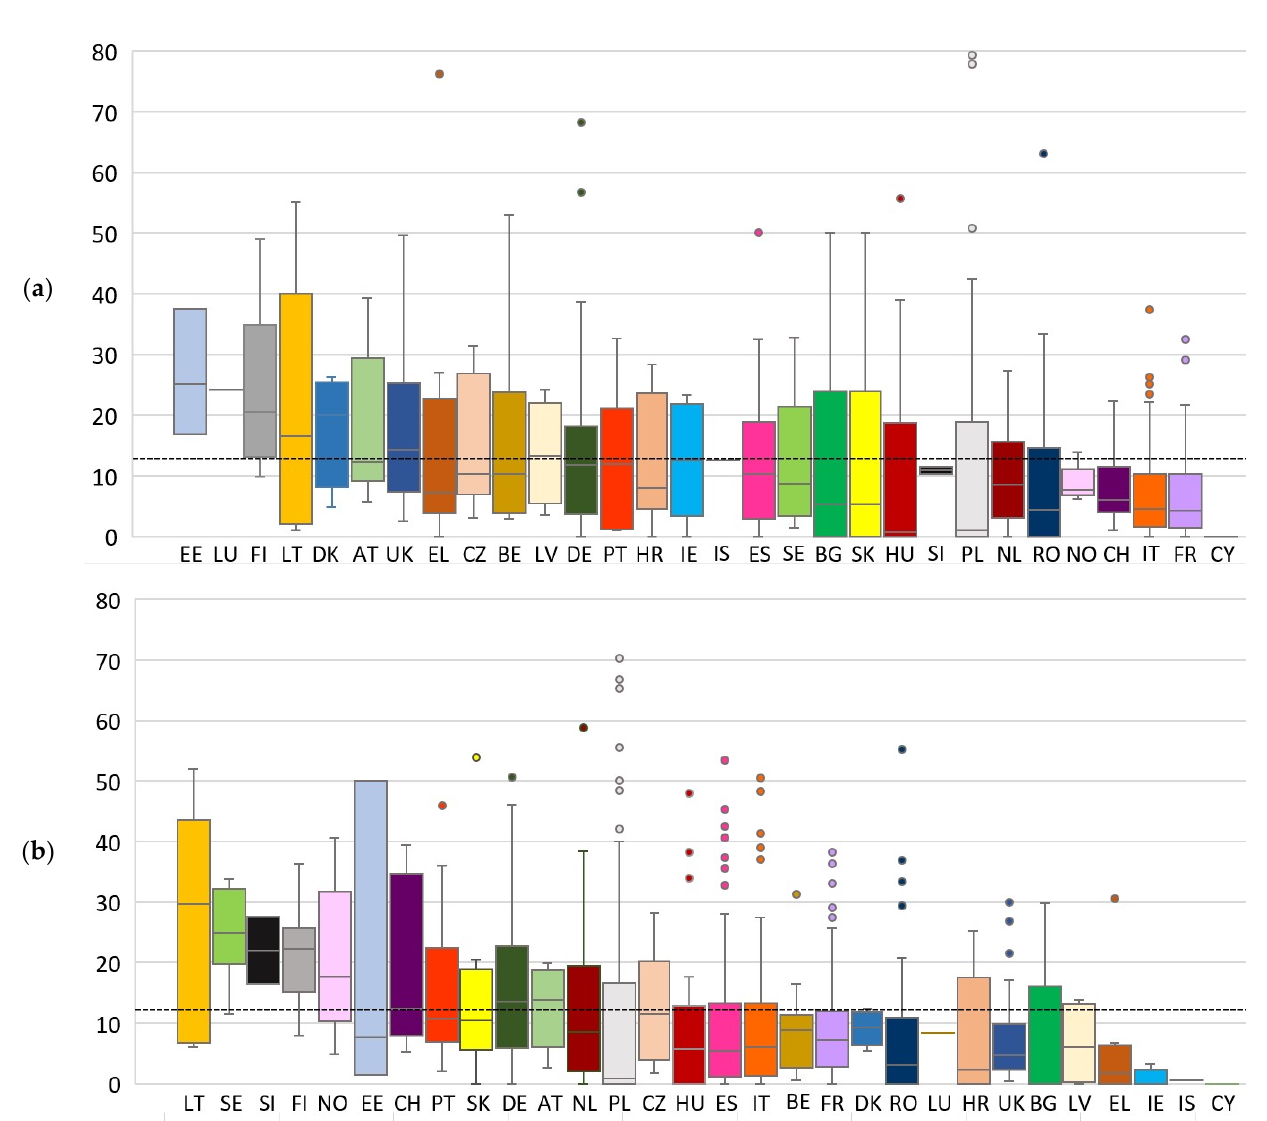
Figure 3. Relative values (%) of observations in green areas ( a ) and forests ( b ). The black line indicates the European average. Relative values were calculated as a percentage ratio between the total number of observations in green areas ( a ) and forests ( b ) and the total number of observations within the city. The lines within box plots indicate the median value. The color is unique for each country so that it is possible to compare different values of observations for the same country respectively for green areas and forests. Full country name and related abbreviation as reported in the figure: Austria (AT); Belgium (BE); Bulgaria (BG); Croatia (HR); Cyprus (CY); Czech Republic (CZ); Denmark (DK); Estonia (EE); Finland (FI); France (FR); Germany (DE); Greece (EL); Hungary (HU); Iceland (IS); Ireland (IE); Italy (IT); Latvia (LV); Lithuania (LT); Luxembourg (LU); Netherlands (NL); Norway (NO); Poland (PL); Portugal (PT); Romania (RO); Slovakia (SK); Slovenia (SI); Spain (ES); Sweden (SE); Switzerland (CH); United Kingdom (UK).